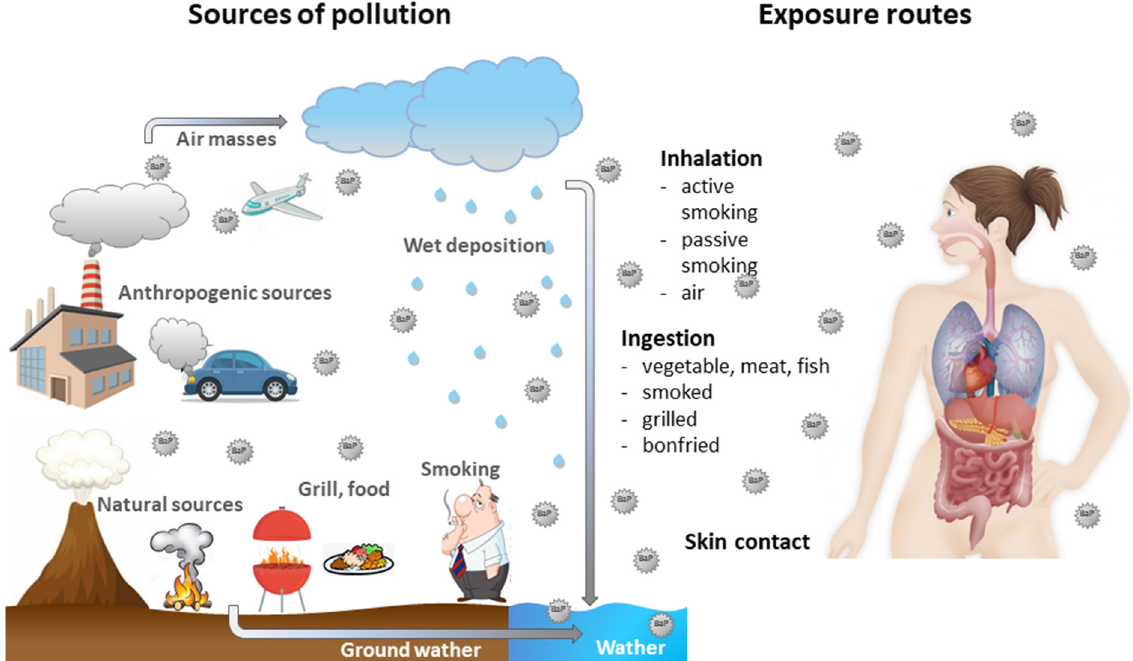
Figure 1. Sources of BaP and its movement in the environment as well as ways of entering the human body.